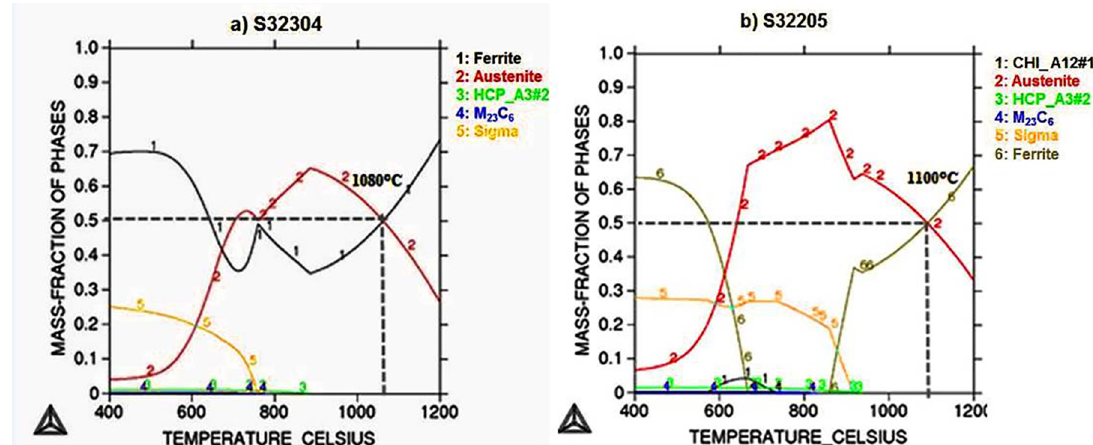
Figure 3. Duplex stainless steels phase equilibrium diagram; a) S32304 and b) S32205